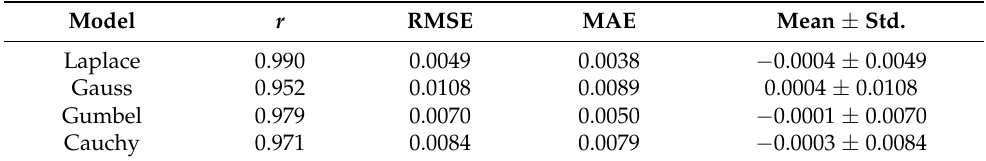
Table 4. The correlation coefficients r , root mean square errors (RMSE), mean absolute errors (MAE), and mean errors ± standard deviations (Mean ± Std.) (simulated minus measured albedo) of four models for albedo with a solar altitude ≥ 5 ◦ on 29 January.